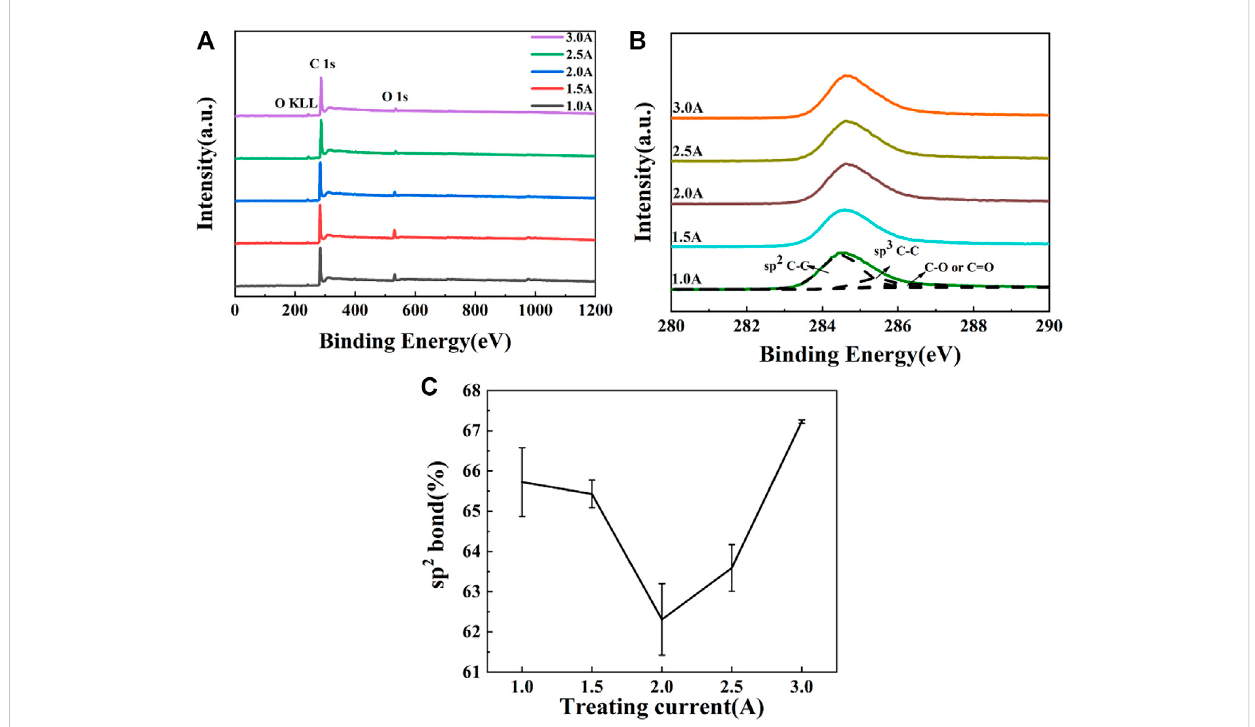
FIGURE 2 XPS of PI substrates treated by carbon plasma with different graphite target currents: (A) full spectra (B) C1s spectra (C) the content of sp 2 bond.